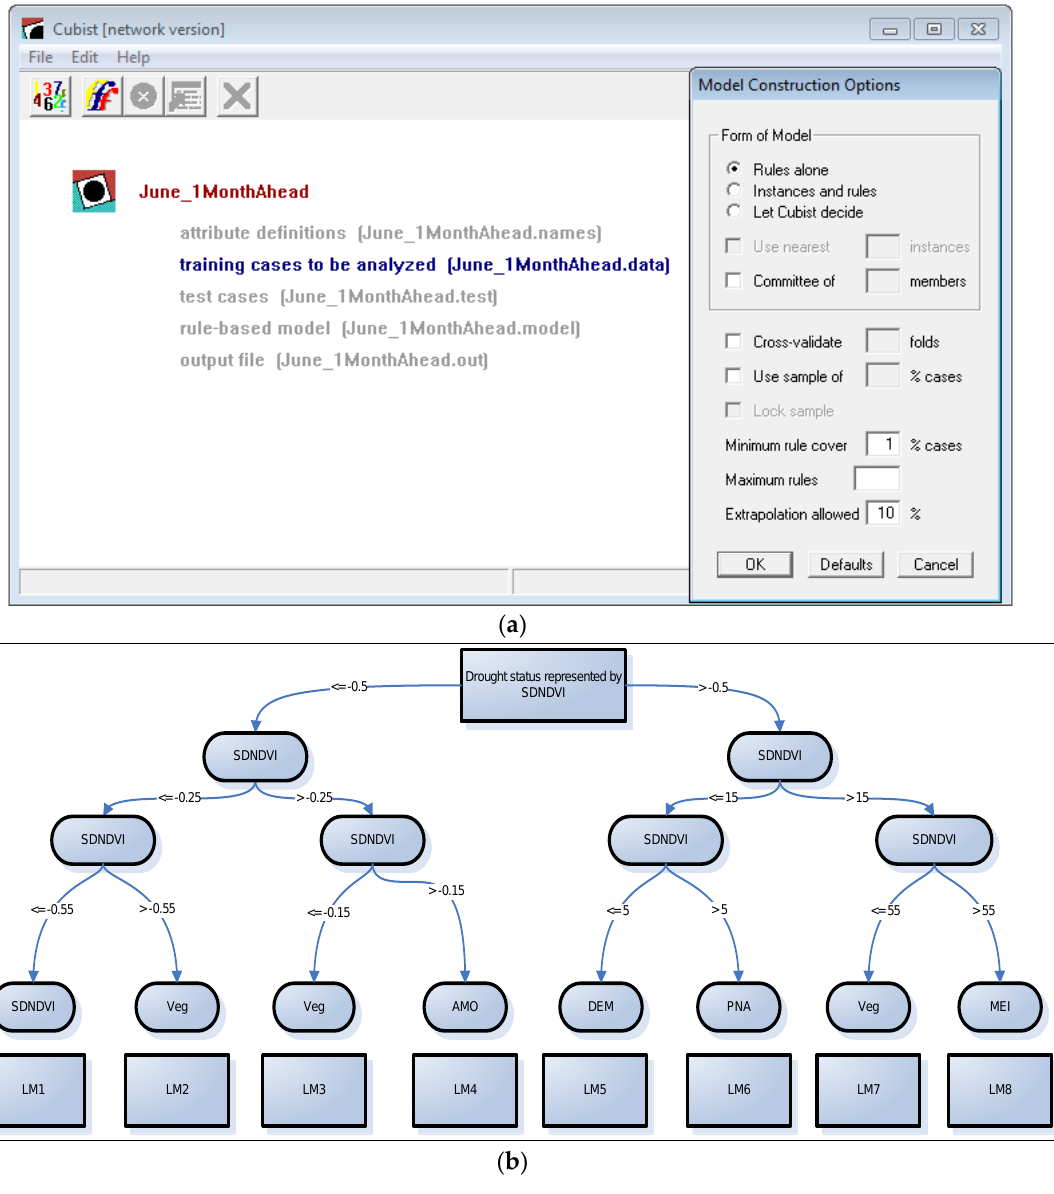
Figure 1. Graphical user interface for RuleQuest Cubist ( a ), and a structure of a model tree with a hypothetical tree and drought tree splits for the Standardized Deviation of Normalized Difference Vegetation Index (SDNDVI) ( b ).